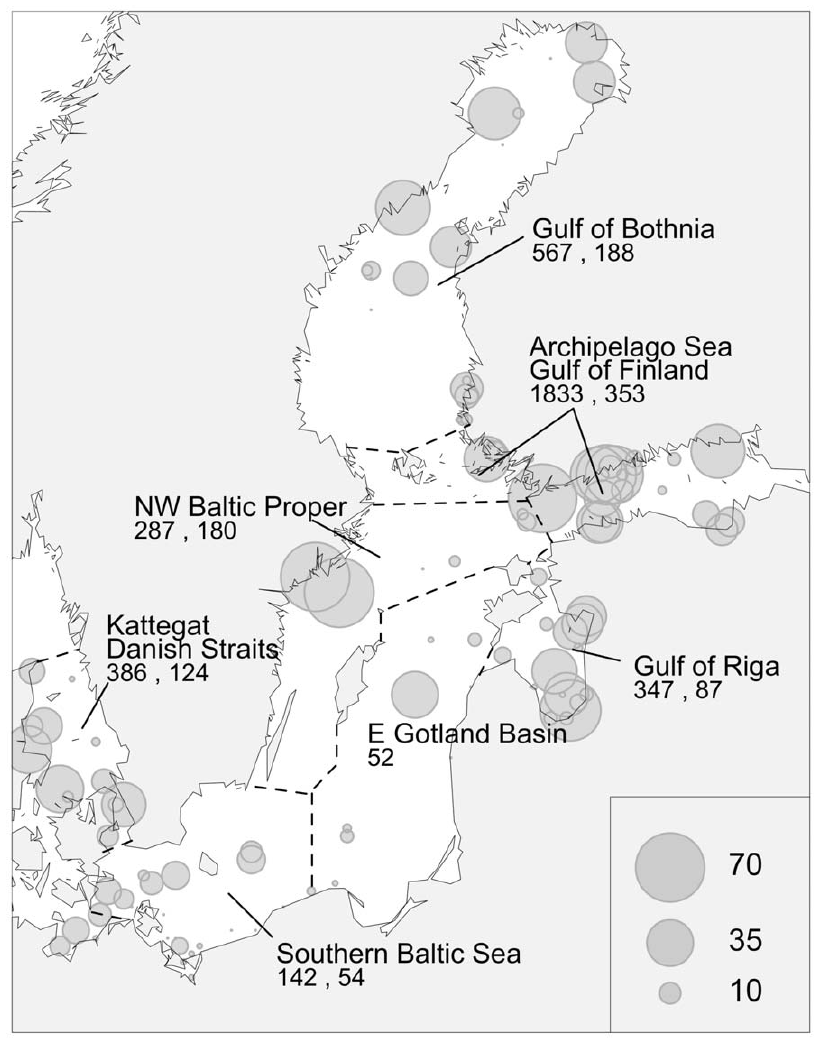
Figure 1. Spatial distribution of the data. Gray symbols mark the sampled stations with the symbol area proportional to the number of samples. Lines and polygons indicate the regions pooled together for long-term analyses. The numbers represent the total amount of spring bloom samples, and the number of basin-wide weakly means used for long-term analysis.